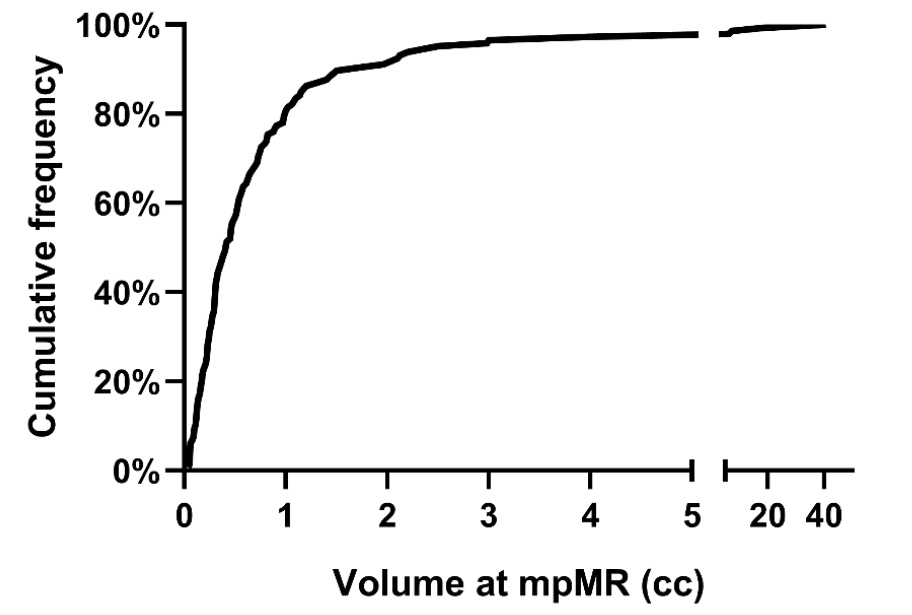
Figure 1. Cumulative frequency of the volume of local disease at mpMRI for patients with positive DCE-MRI. Abbreviations: mpMRI: multiparametric magnetic resonance imaging; DCE-MRI: dynamic-contrast-enhanced magnetic resonance imaging.